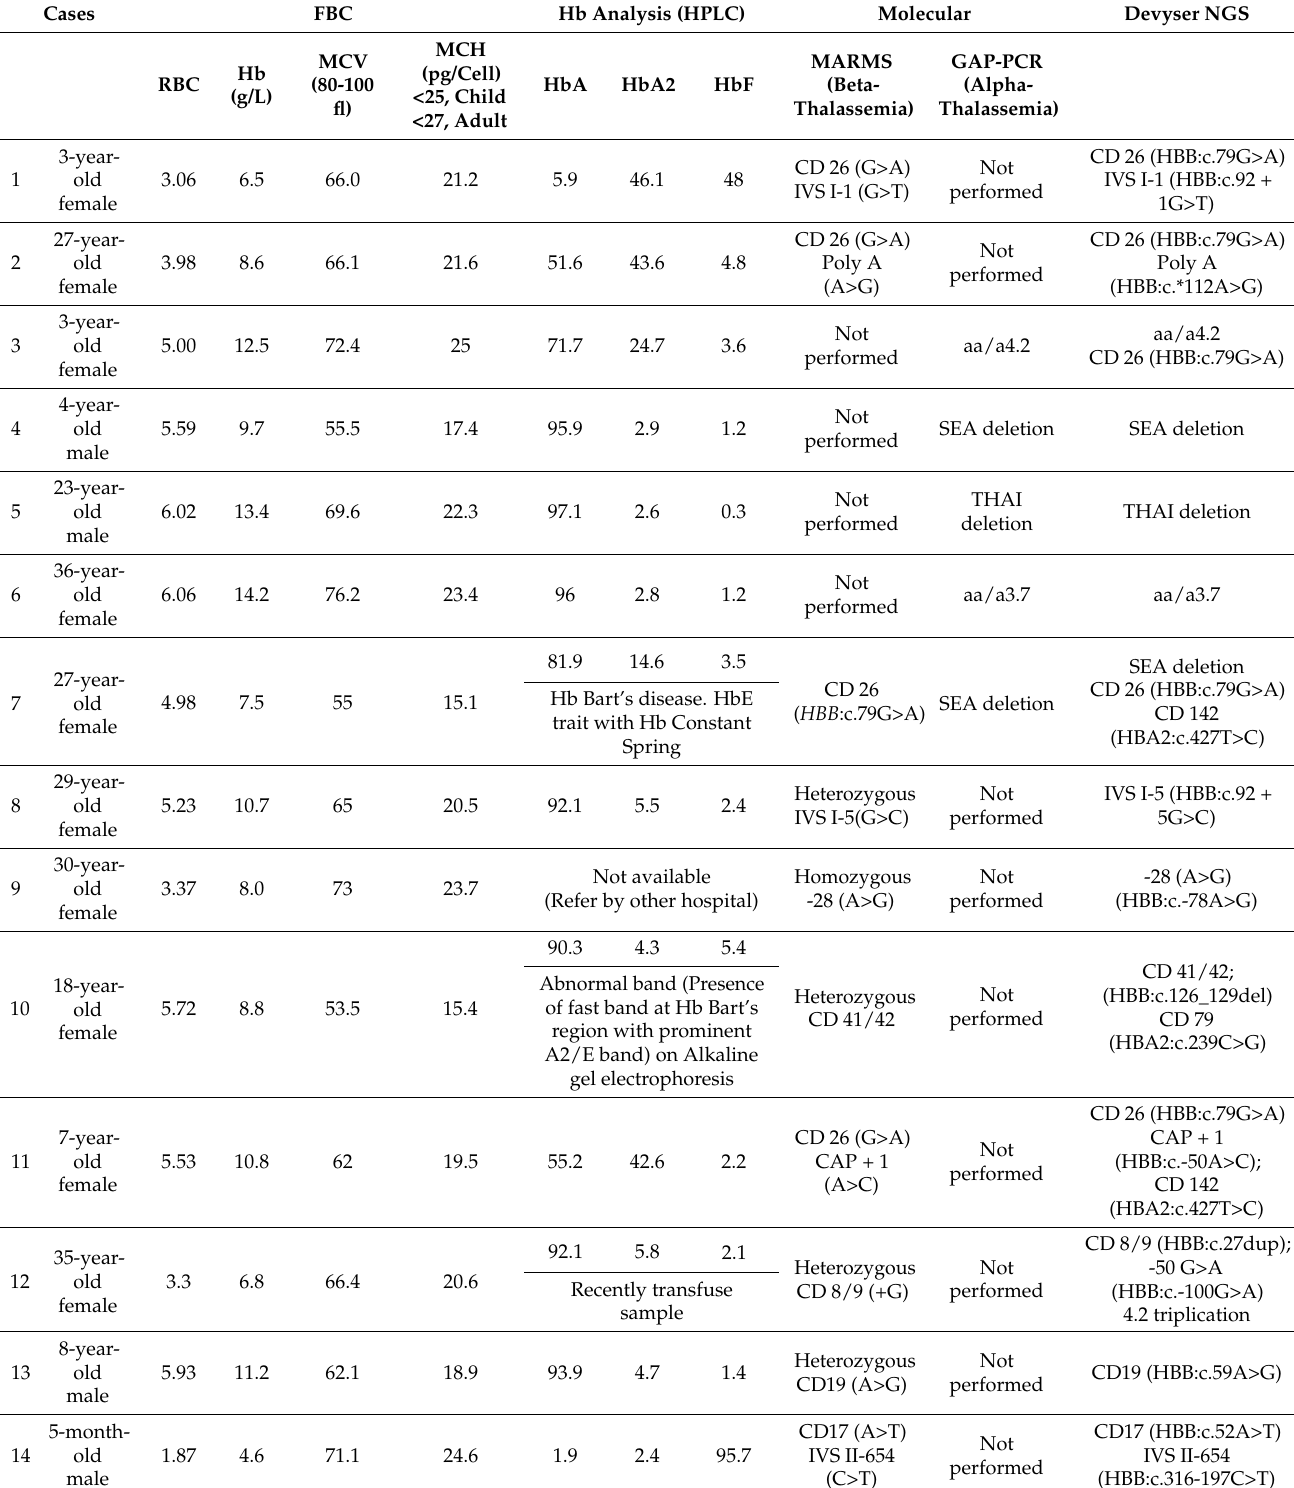
Table 2. List of patients, FBC results, HB analysis results, molecular status, and DNA/RNA sequencing